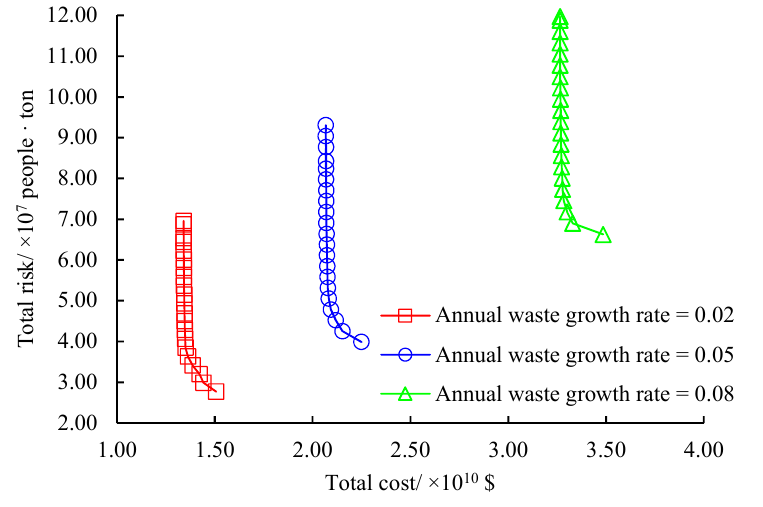
Figure 11. Effects of annual waste growth